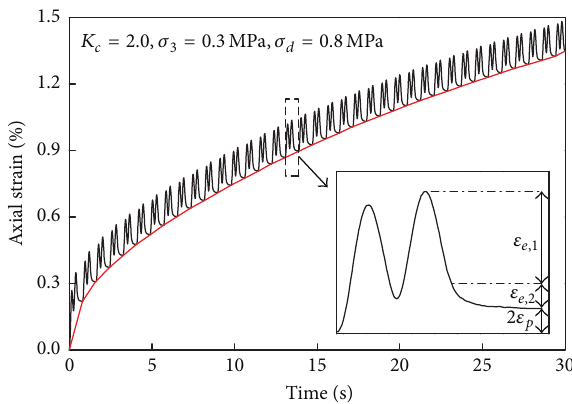
Figure 6: Development style of the axial deformation with loading